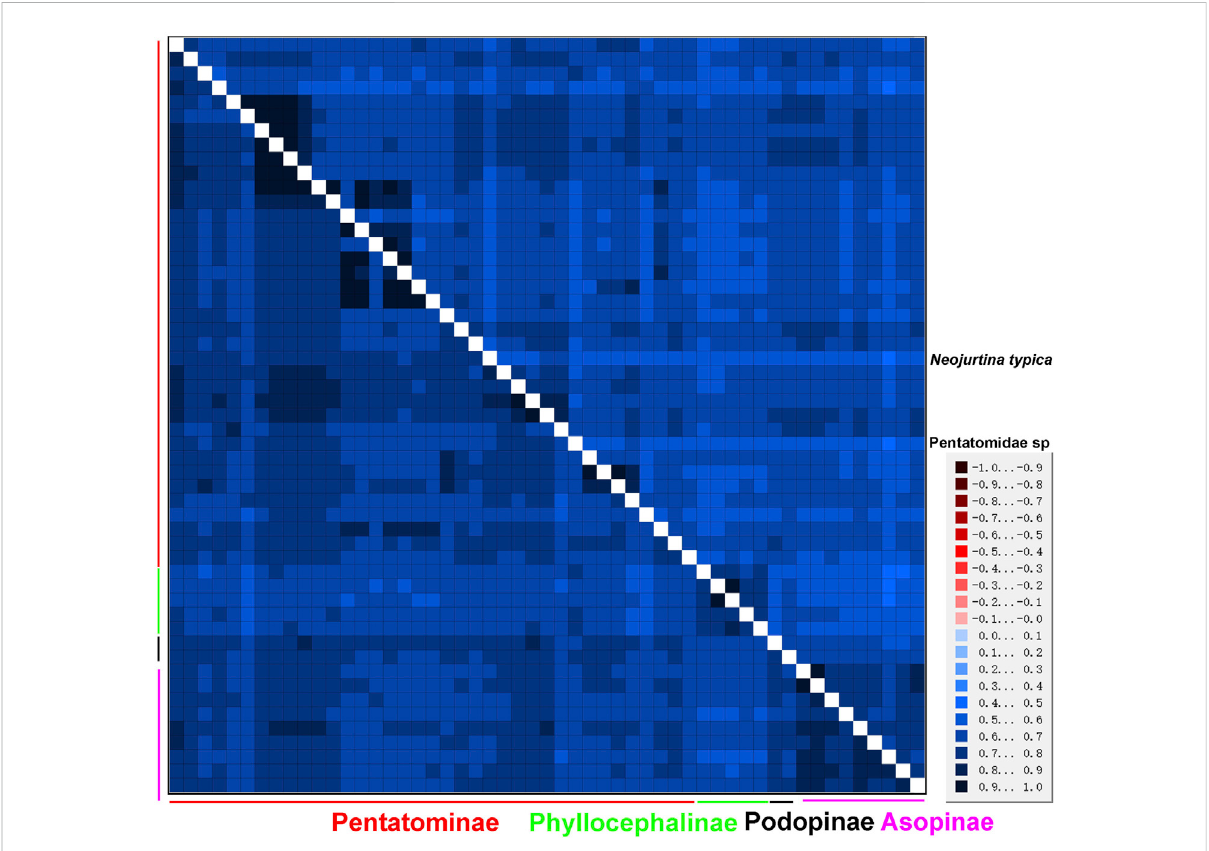
FIGURE 9 AliGROOVE analysis of 53 Pentatomidae species based on PCG12 (lower triangle) and PCG123 (upper triangle). The mean similarity score betweensequencesisrepresentedbycoloredsquares,basedonAliGROOVEscoresrangingfrom − 1,whichindicatesagreatdifferenceinratesfrom the remainder of the data set, that is, heterogeneity (red coloring), to +1, which indicates rates that matched all other comparisons (blue